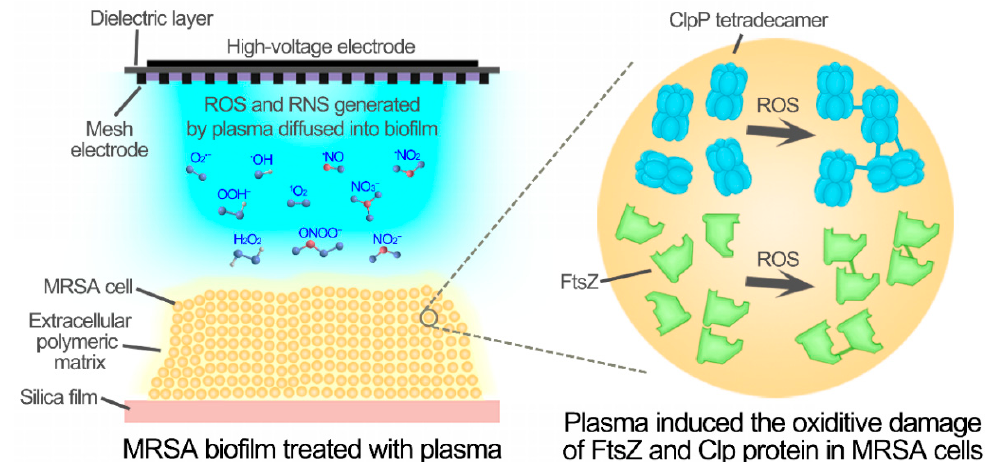
Figure 7. The aggregation and inactivation of SaFtsZ and SaClpP induced by the reactive species of CAP.